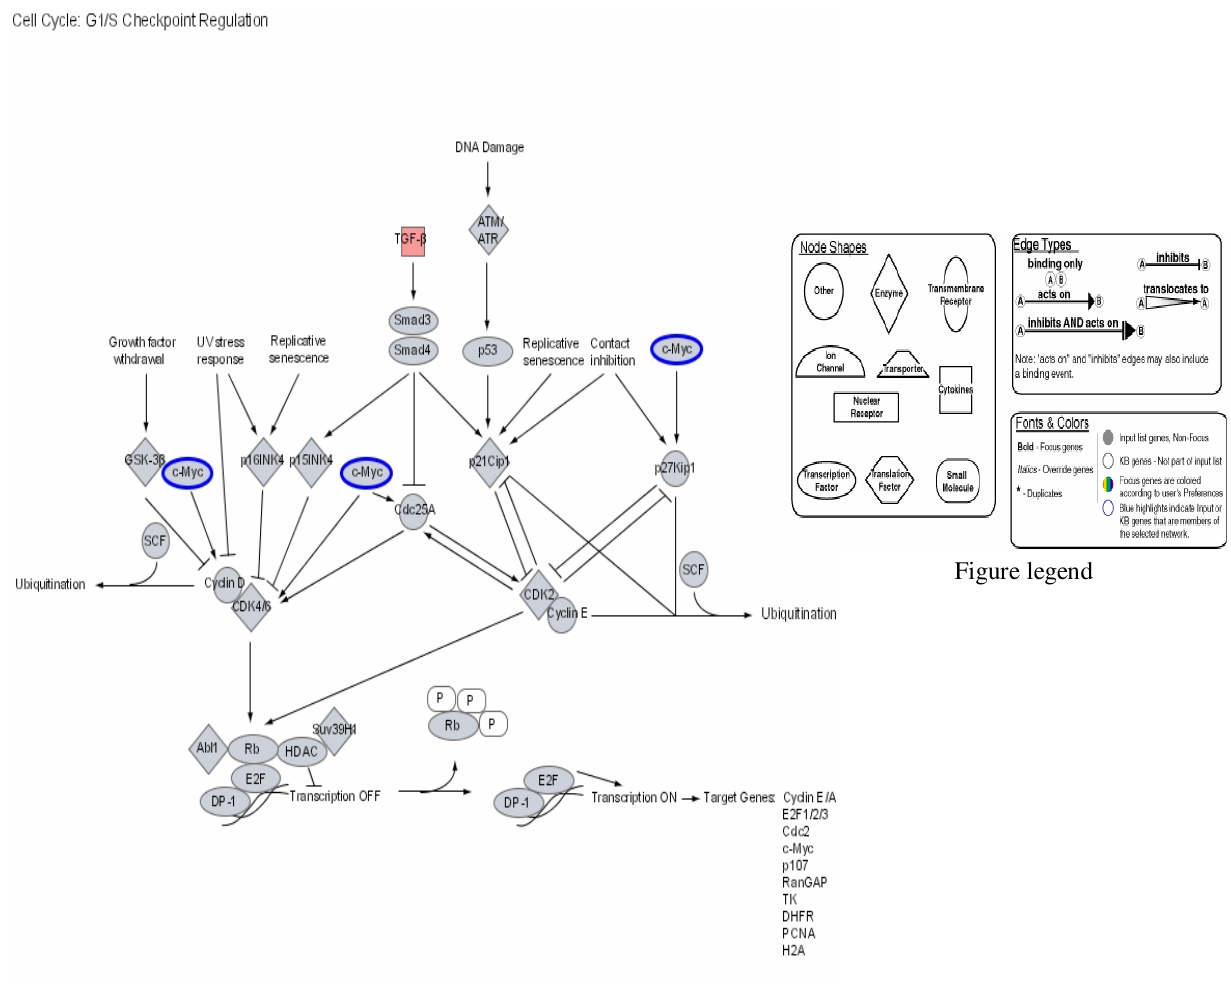
Figure1: Modulation of cell cycle GI/S checkpoint regulation by mercury : Activation of TGF- β and repression of